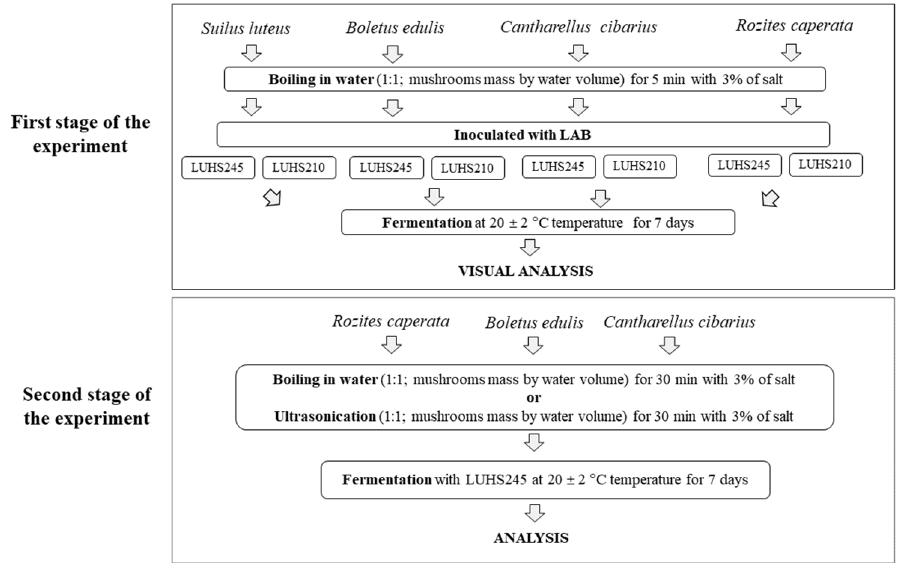
Figure 2. Principal scheme of the experiment (LUHS210—fermented with L. casei LUHS210; LUHS245—fermented with L. uvarum LUHS245).